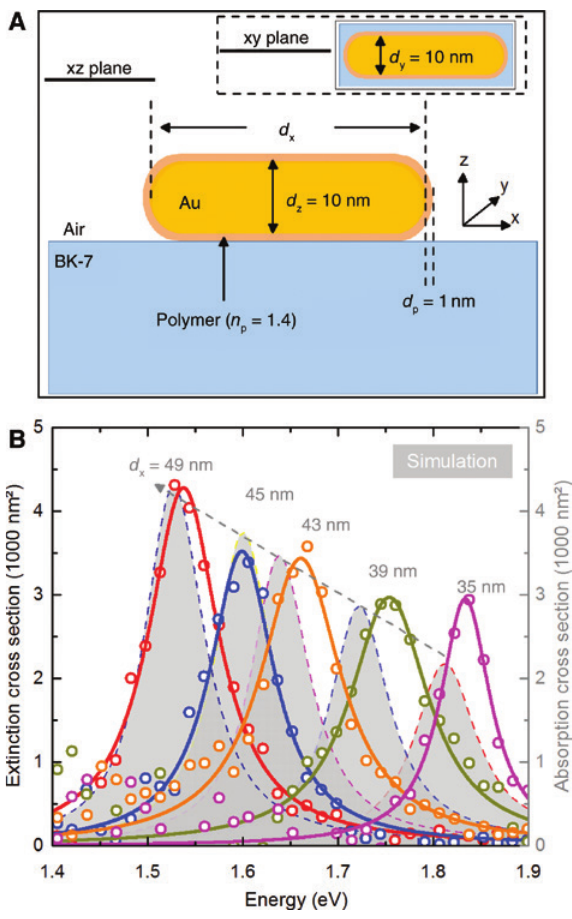
Figure 4: Comparison between experiment and FDTD calculations. (A) The sample geometry used in the FEM calculations. The gold rods are modeled as prolate spheroids with a longitudinal axis length d , x = 10 nm and a height of d = 10 nm at an a transverse axis length d y z air-BK-7 interface. The rod is coated with a polymer shell of thickness = 1 nm with a refractive index of n = 1.4. (B) A comparison of the of d p P calculated absorption cross sections for different d shown as grey- x shaded areas with respect to the experimentally measured extinction cross sections (circles) and their Lorentzian fits (solid